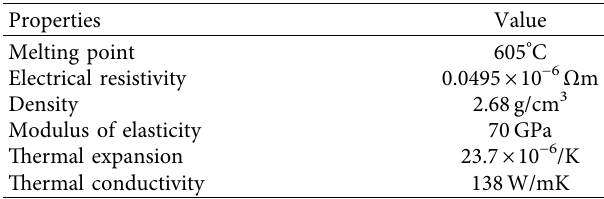
Table 2: Properties of AA 5052.